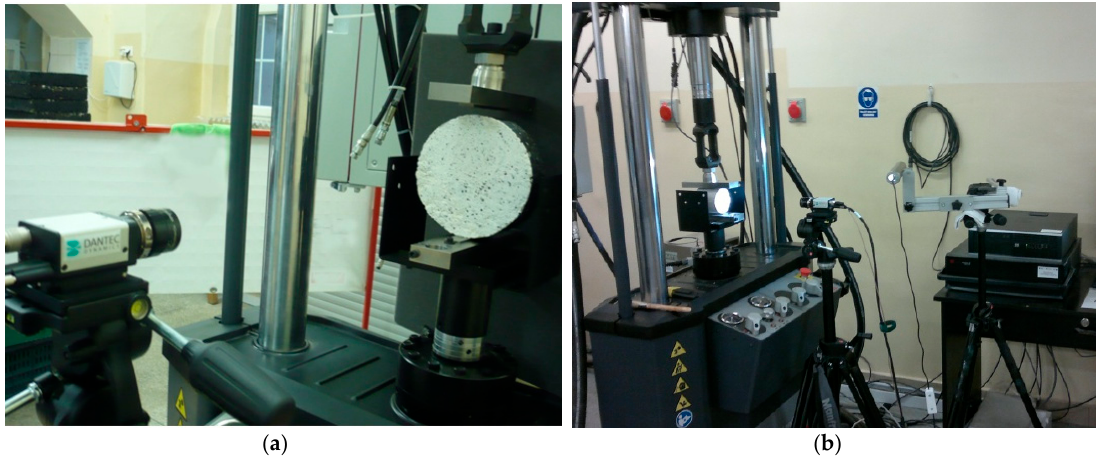
Figure 8. Laboratory stand using the DIC method for the indirect tensile test: ( a ) HMA sample; ( b ) soil sample [40,41].